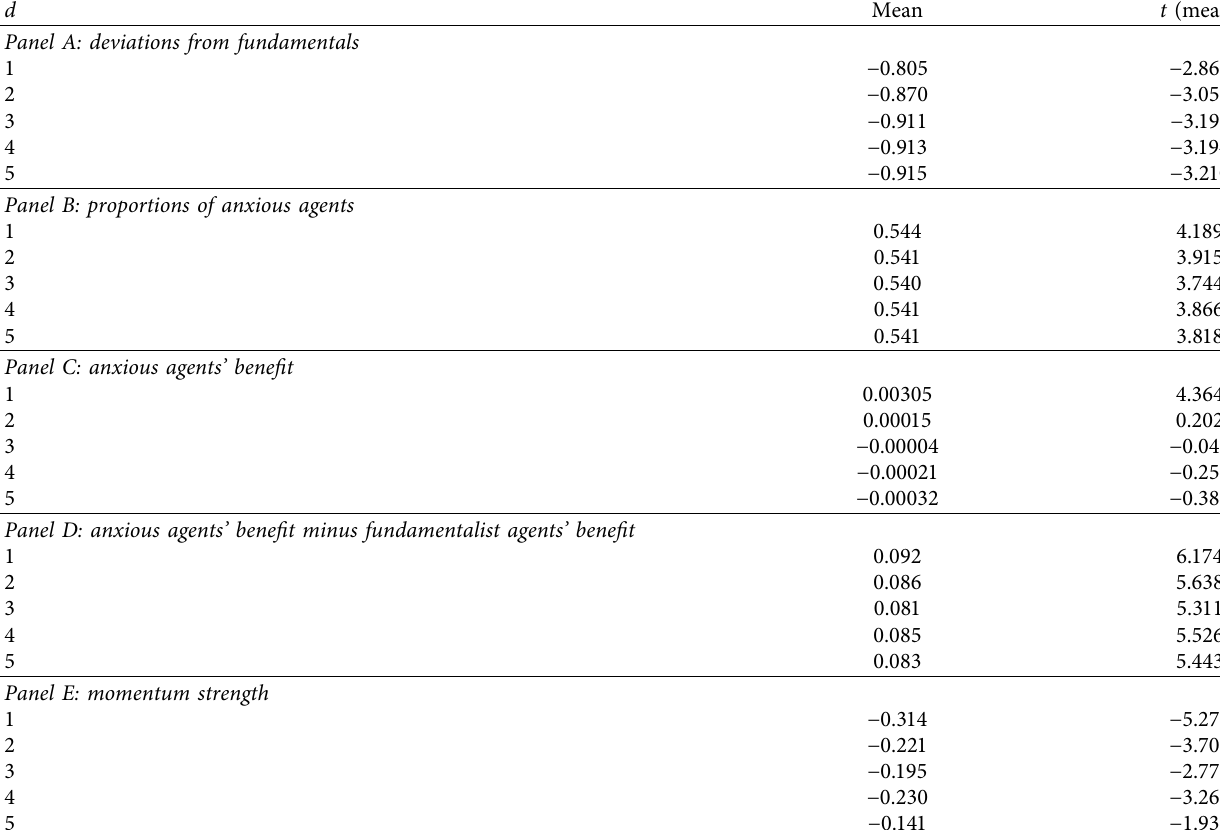
Table 2: Simulations with evolutionary proportions. Note: This table presents deviations from the fundamental information, market proportions of anxious agents, the benefit of the anxious agent’s strategy, the difference in benefits between the anxious and fundamentalist agents, and the momentum strengths. The indicator of behavioral hesitation (denoted by d ) ranges from 1 to 5. When d equals 1, the ) � p + λ × F x expectation for price of the anxious agent can be written as E x t ( p j,t + j,t j,t − 1 . Hence, the anxious agent does not embody 1 hesitation since the agent only relies on the single-period forecast error in such a case. However, hesitation begins to emerge if d is 2 or over 2 since the agent refers to multiperiod forecast errors. For the sake of inferring statistical significance, we perform a one-sample t -test in every simulation window. Furnished with such exercises, the averages of the t -statistics across windows are obtained. Gatti and Grazzini [88] and Garc´ıa-Magariño et al. [89] also employ the same inference